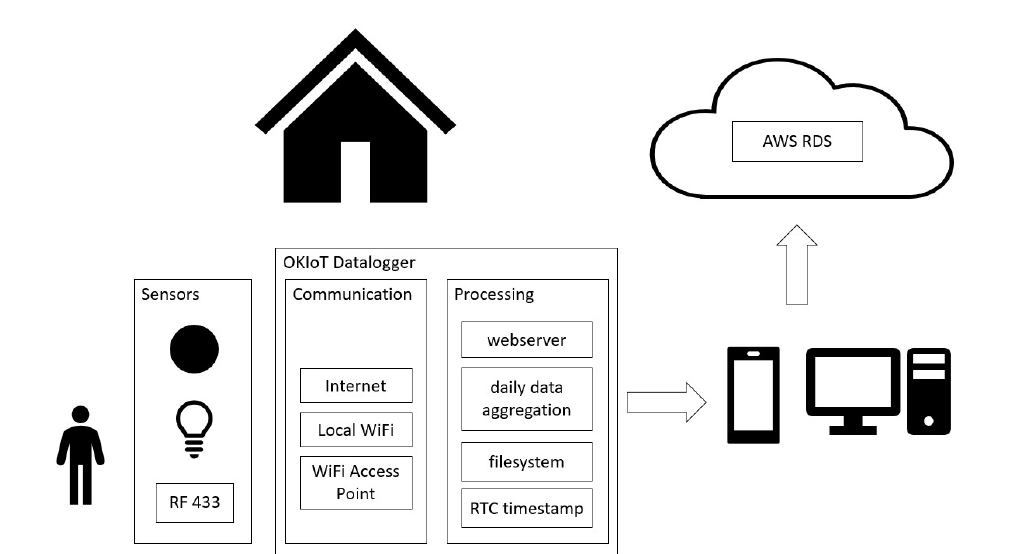
Figure 5. Test bed data acquisition infrastructure. Presence and room light switch events are recorded by the data logger, aggregated, and then sent to cloud through intermediary device.